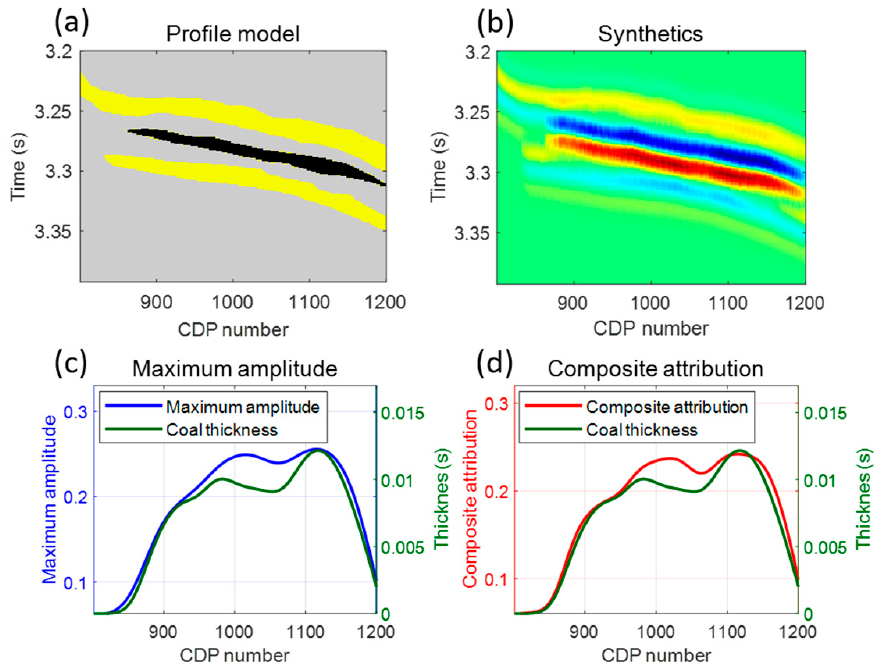
Figure 9. Lateral variable-thickness model comprising sandstone layers both above and below a single coal seam: ( a ) Profile model; ( b ) Synthetics; ( c ) Maximum amplitude; ( d ) Composite attribu- tion.